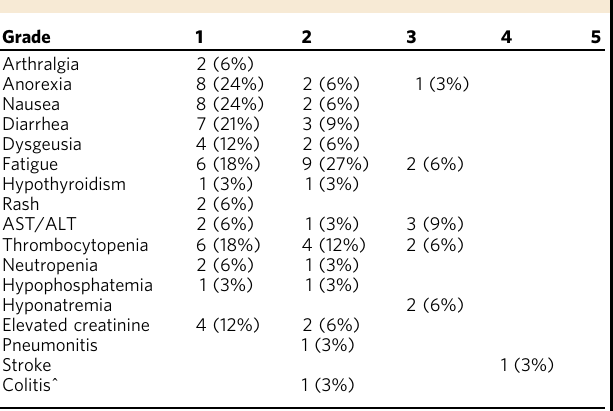
Table 2 Patients reporting any treatment emergent toxicities.